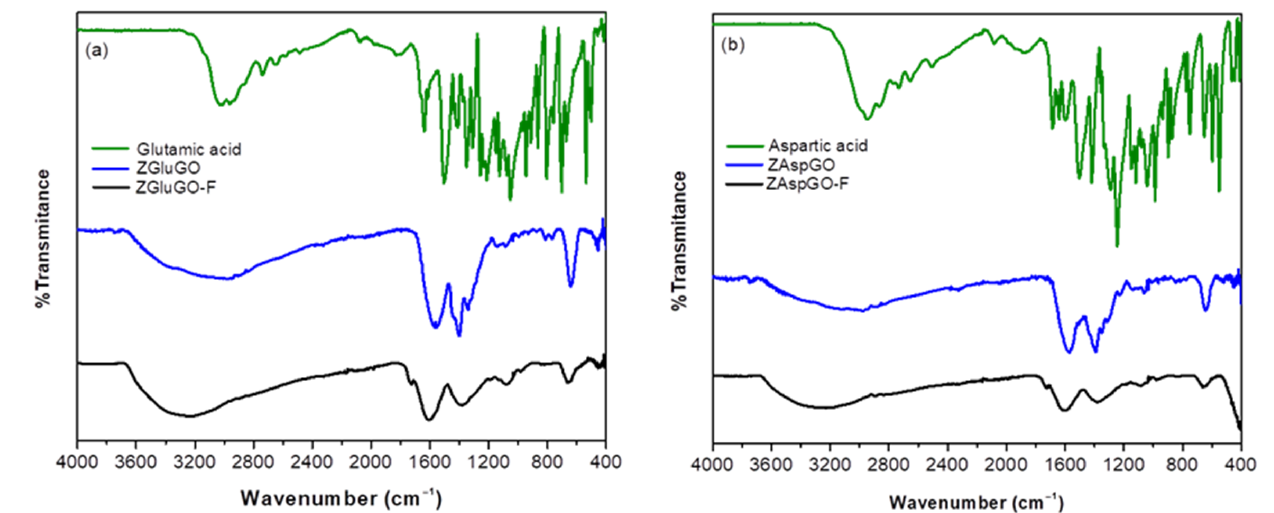
Figure 5. FTIR spectra of ( a ) glutamic acid, ZGluGO, and fluoride-treated ZGluGO (ZGluGO-F). ( b ) aspartic acid, ZAspGO, and fluoride-treated ZAspGO (ZAspGO-F). After the coordination of GO and aspartic acid or glutamic acid to the zirconium atoms by carboxylate groups, it was observed that the characteristic signals of the amino acids (OH and NH 2 ) overlapped, creating a wider signal with lower intensity in a range of 3500–3000 cm − 1 due to the presence of water of hydration and crystallization and the